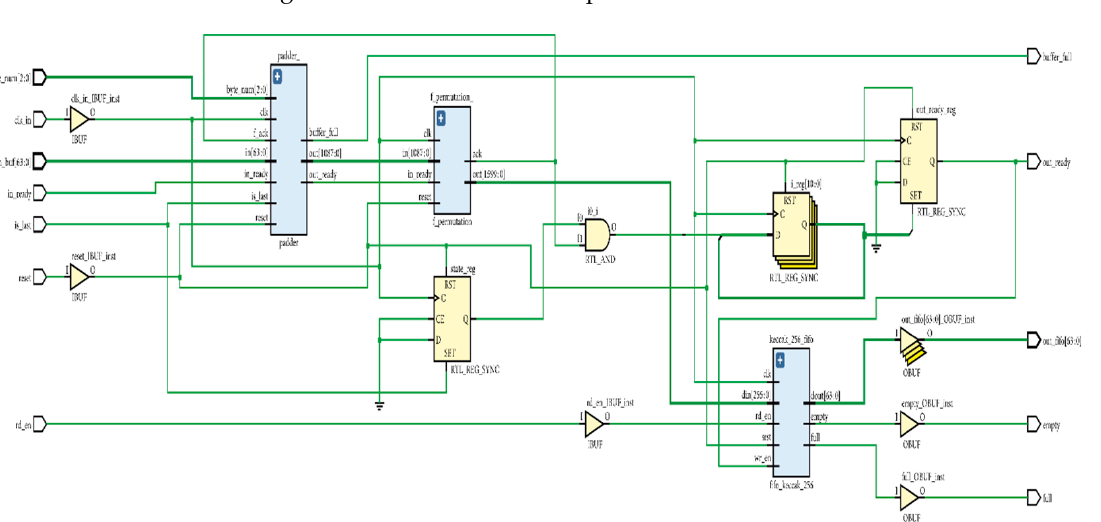
Table 1. Comparison of different HW/SW Keccak implementation.